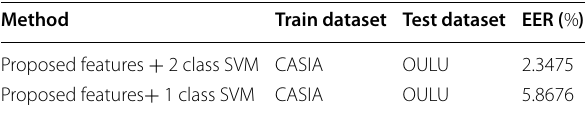
Table 6 Error rates when features are trained on CASIA and tested on OULU